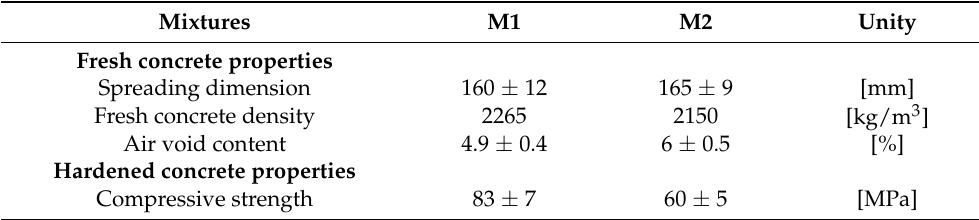
Table 1. Test results of the two mixtures.